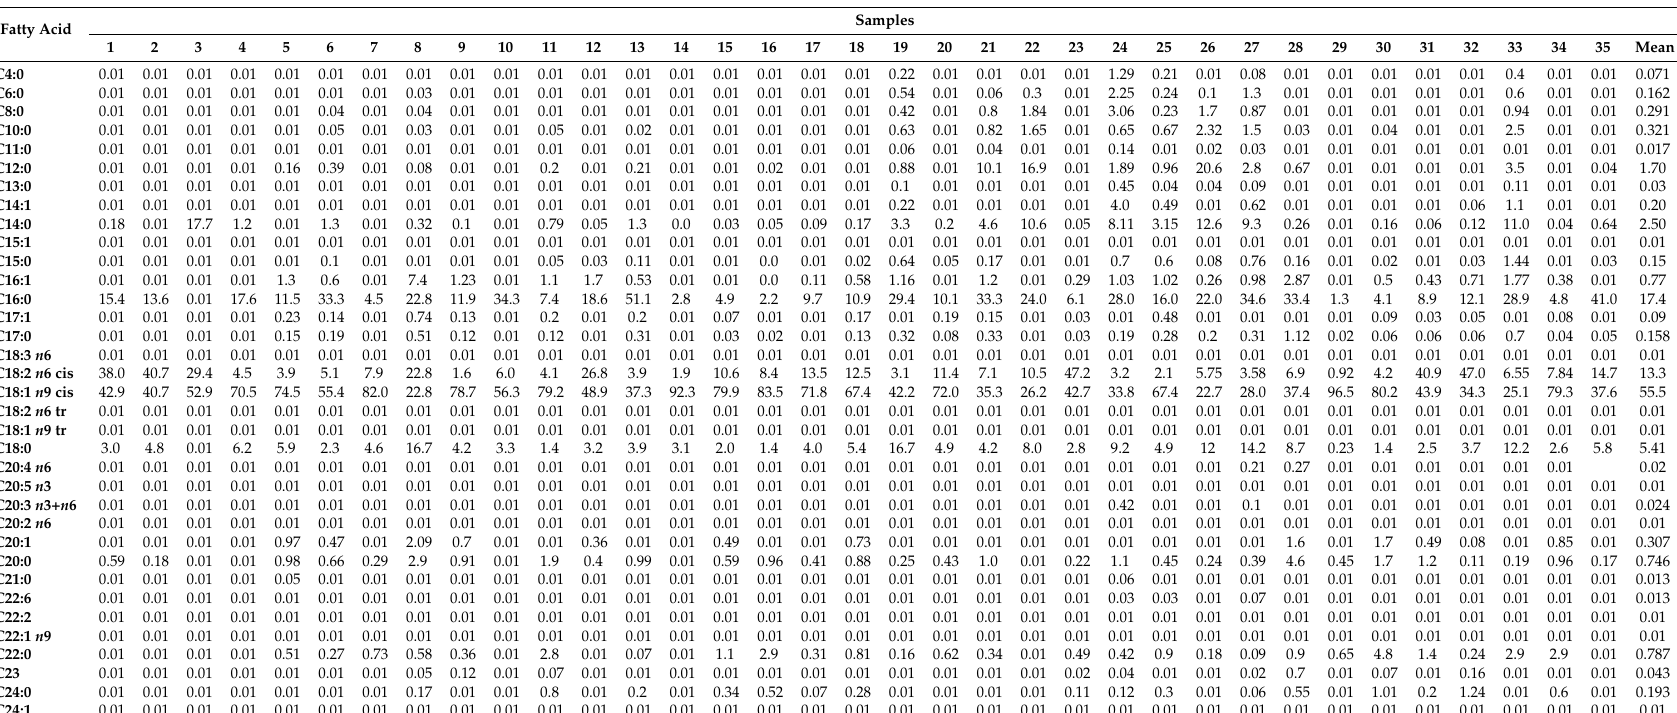
Table 2. Fatty acids composition (% of total fats) of gluten-free